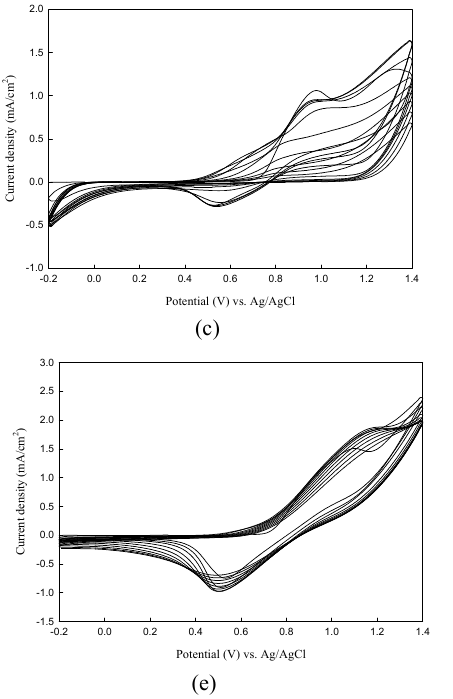
Potential (V) vs. Ag/AgCl